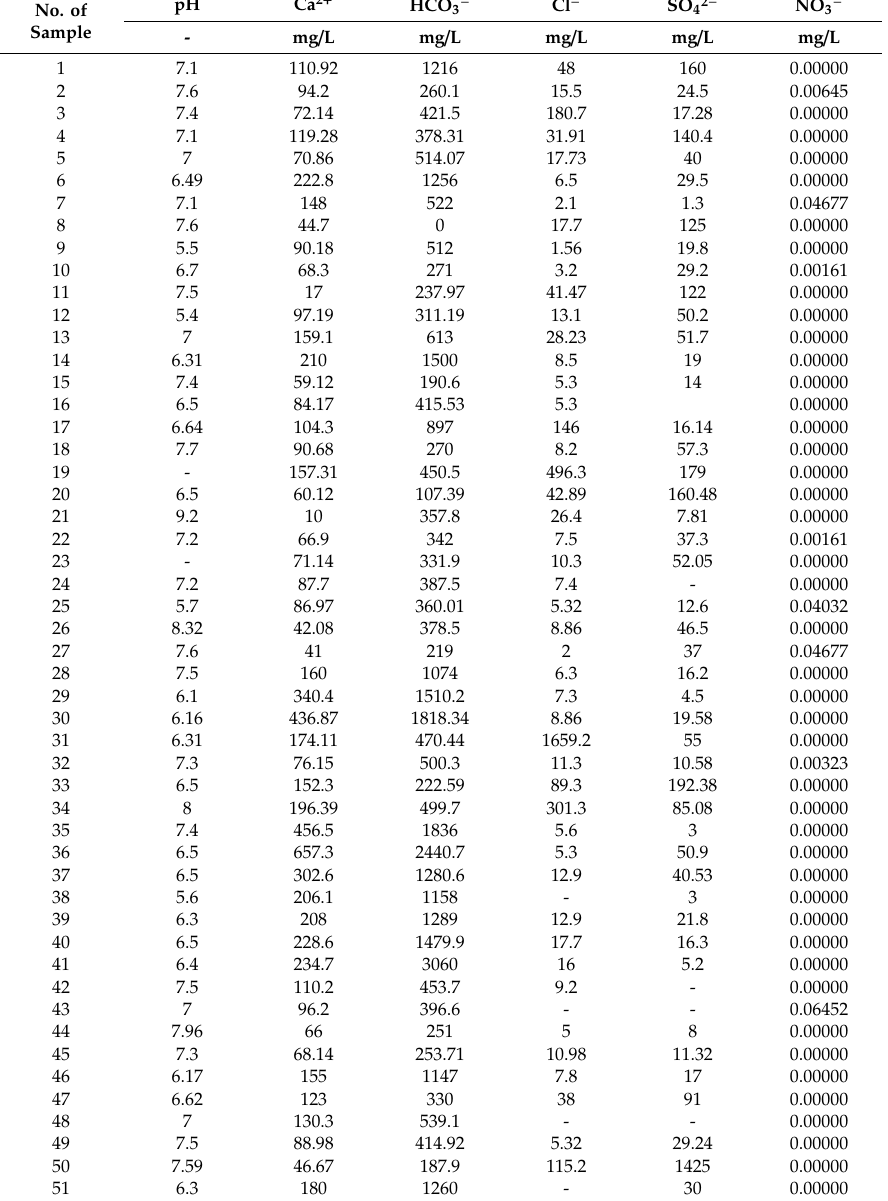
Table A1. Properties of selected bottled mineral waters—some results from all of the analyzed waters. No. of